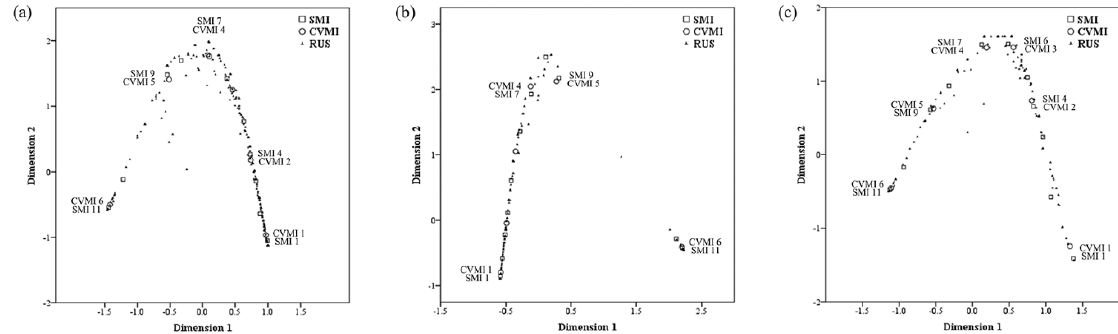
The observed correspondence was CVMI 1-SMI 1, CVMI 4-SMI 7, CVMI 5-SMI 9, and